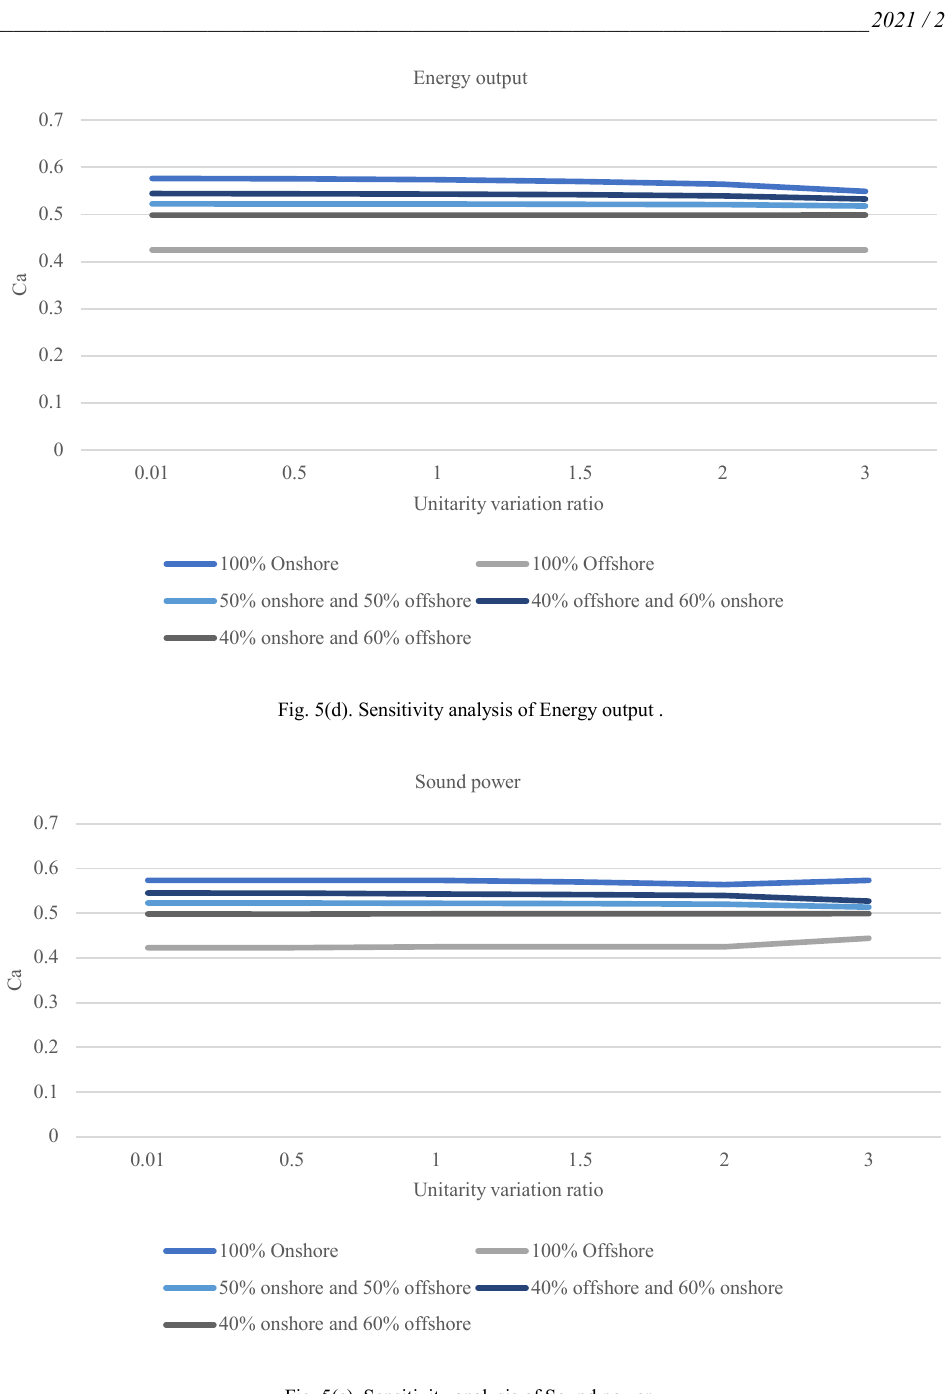
Fig. 5(e). Sensitivity analysis of Sound